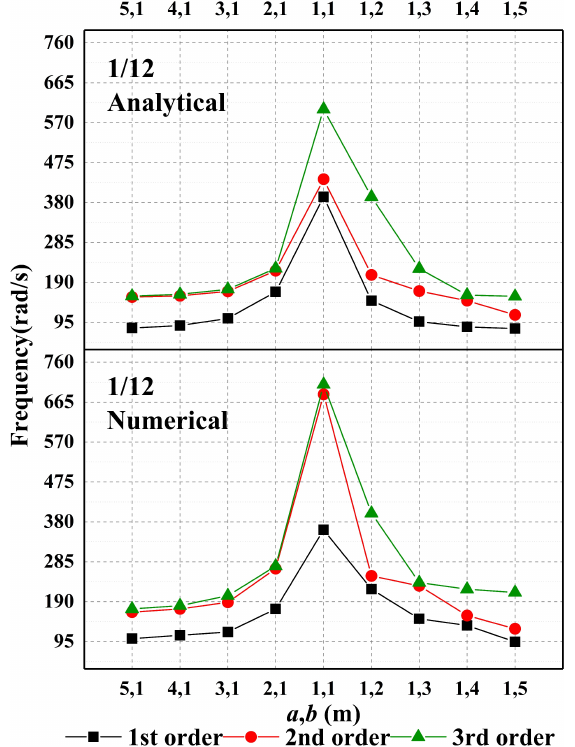
Figure 12: Comparison of natural frequencies under different length width ratios when the rise span ratio is